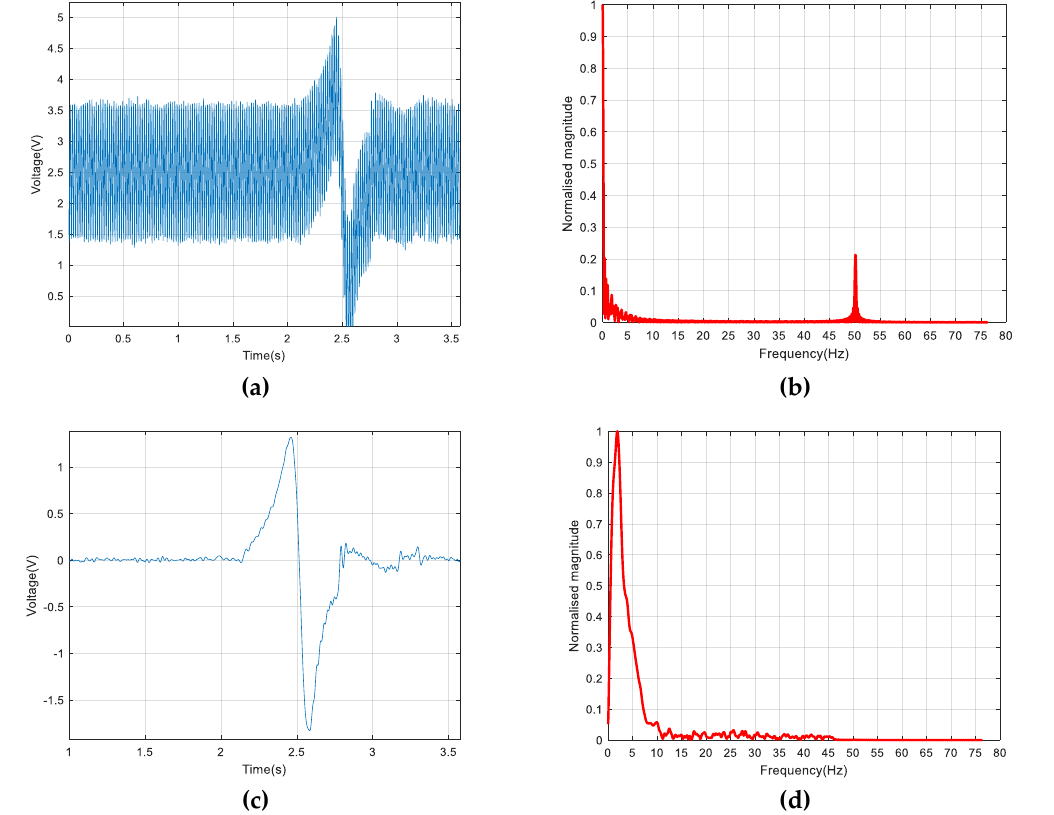
Figure 20. Results of experiment 1: ( a ) Measurement signal waveform; ( b ) spectrum of the measurement signal waveform; ( c ) filtered signal; and ( d ) spectrum of the filtered signal.